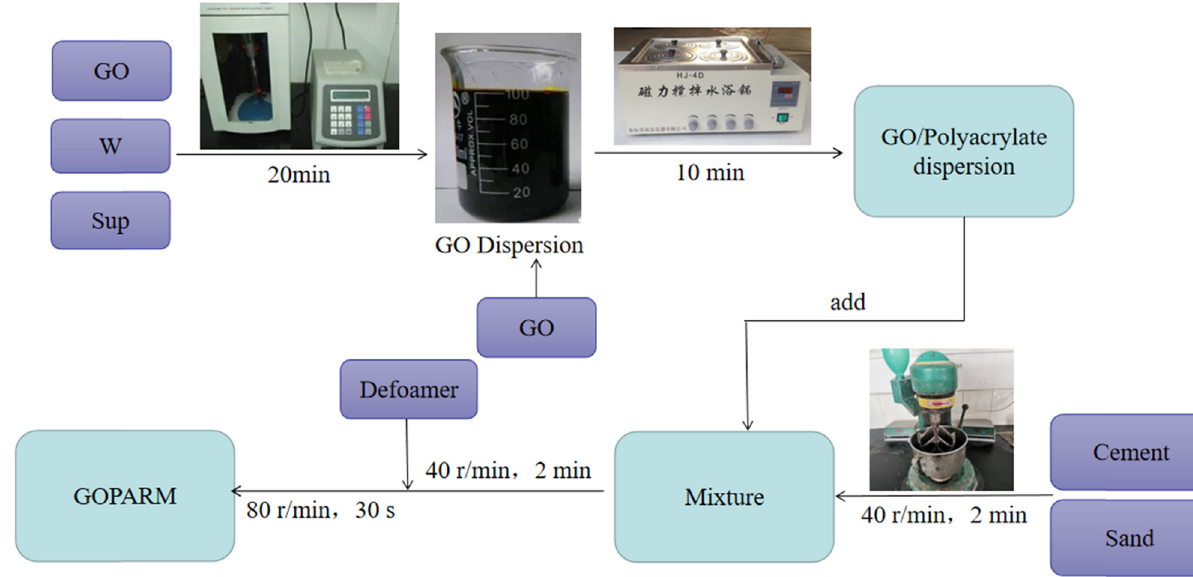
Figure 1: Preparation process of GOPARMs.